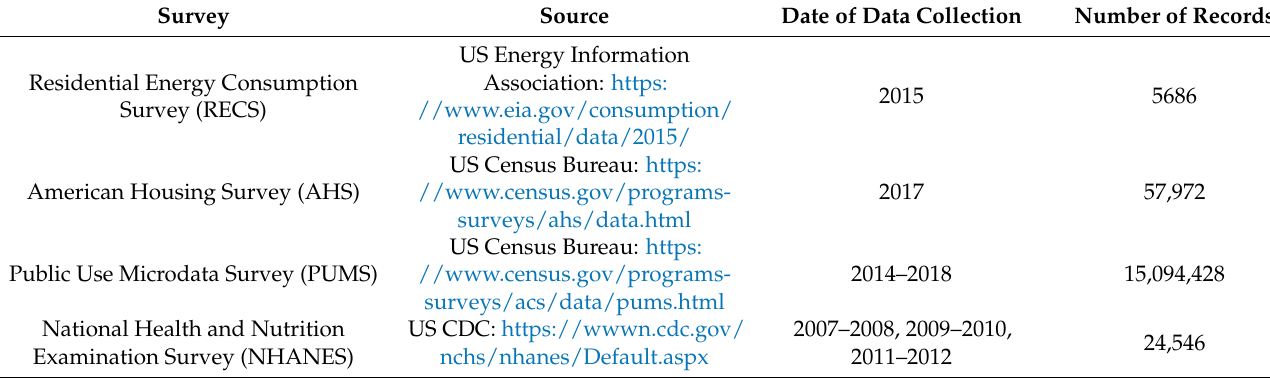
Table 2. Data sets used in this version of the RPGen. Note: NHANES data derived from EPA’s httk.